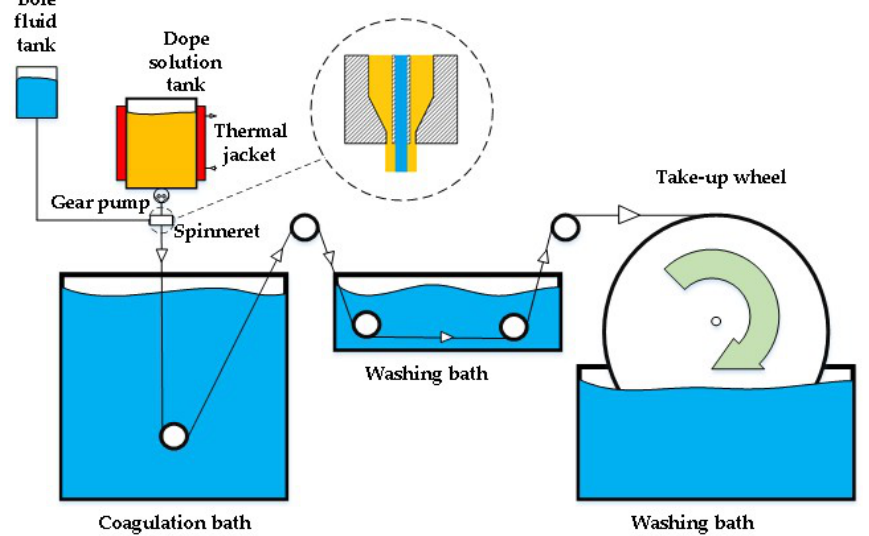
Figure 1. Hollow-fiber membrane-spinning apparatus.